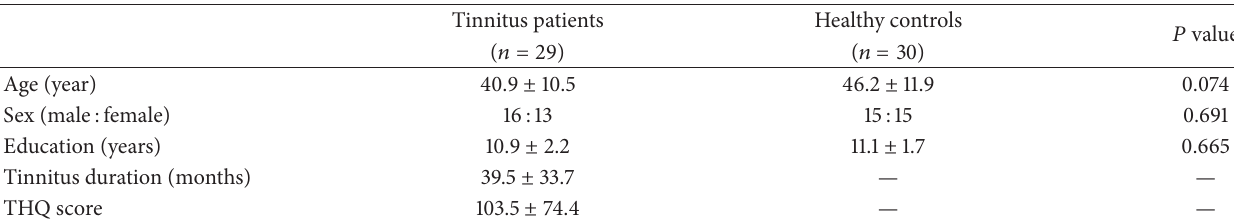
Table 1: Characteristics of the